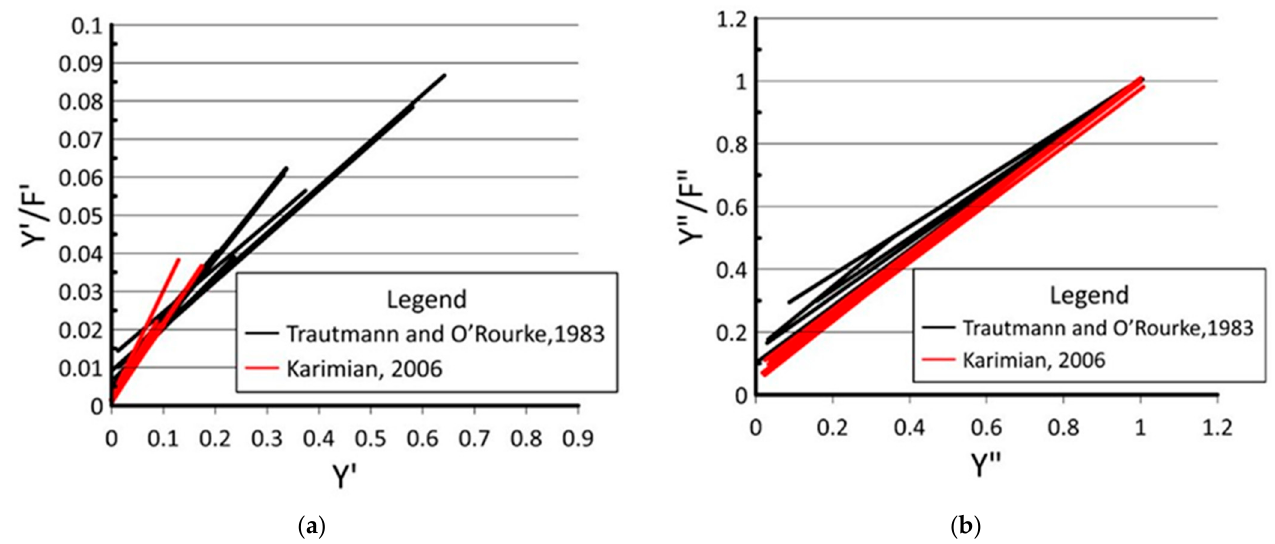
Figure 7. Diagram of ( a ) Single- and ( b ) Double-normalization for medium sand. Experiments performed by [7,28].